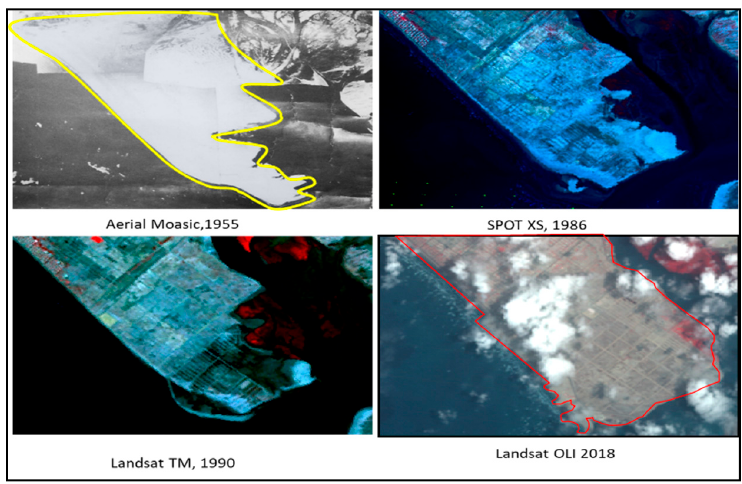
Figure 11. Expansion of Defense Phase VIII over land reclaimed from the Arabian Sea during the 1955–2018 period.